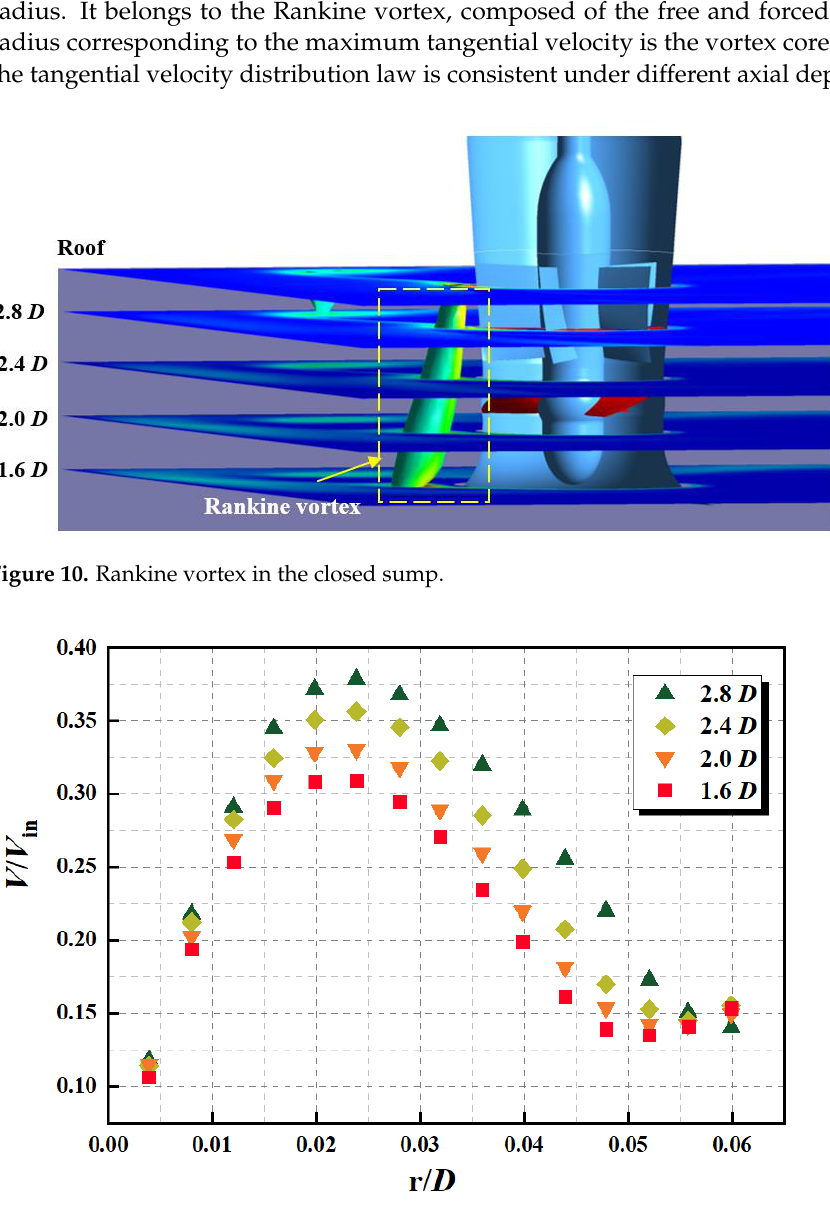
( e ) Figure 12. Vorticity field distribution near the roof at different time points. ( a ) 1/5T, ( b ) 2/5T, ( c ) 3/5T, ( d ) 4/5T, ( e ) T.